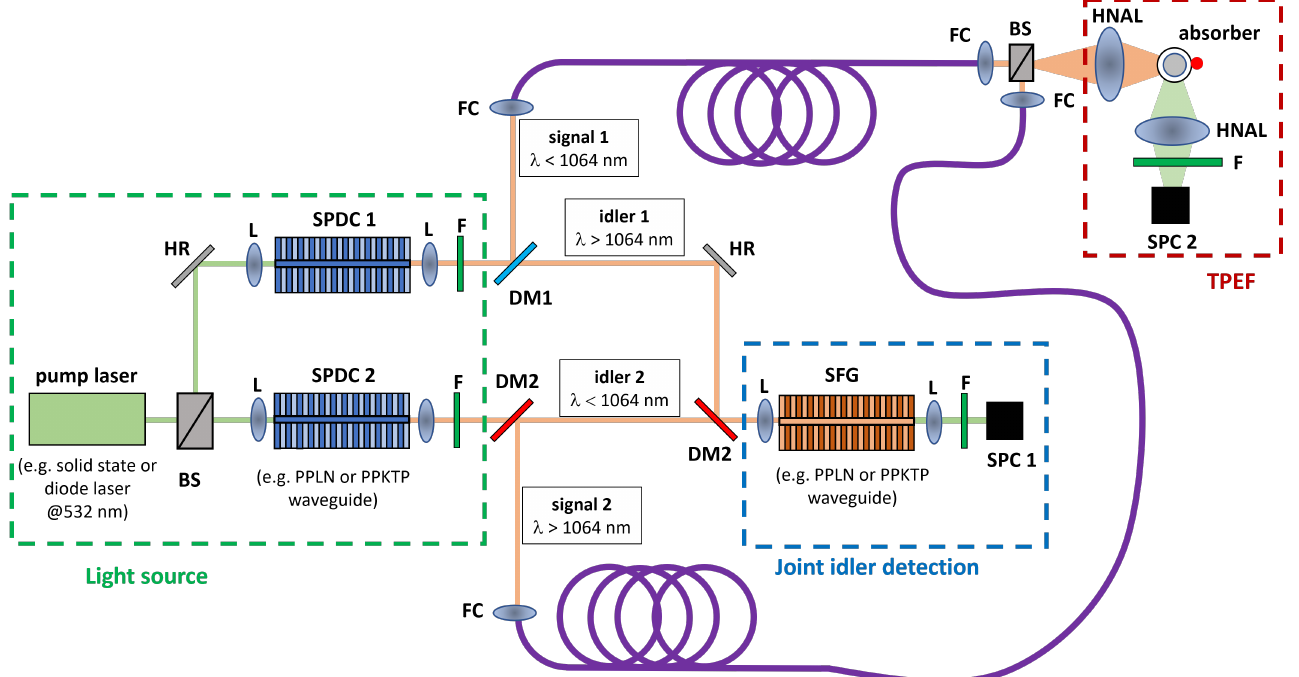
Figure 4. Sketch of a two-photon excited fluorescence (TPEF) experiment utilizing photon pairs from a heralded two-photon source to excite fluorescence in a single absorber (e.g., a dye molecule with a nano-antenna). A laser at a visible wavelength (e.g., 532 nm) is used to pump SPDC in two waveguide PP crystals (SPDC1 and SPDC2). The idler and signal photons of the SPDC sources are separated by dichroic mirrors (DM). Joint detection of the idler photons from both sources is performed in a waveguide nonlinear crystal by SFG and subsequent detection of an up-converted photon at a single photon detector (SPD 1). If two photons are jointly detected at the SFG crystal, two correlated/entangled photons must be in the two other channels. The delay between these two heralded photons can be controlled in fibers and/or by other means. The two-photons are reunified at a beam splitter (BS) and focused tightly onto the two-photon absorber using high NA optics (HNAL). The emitted fluorescence photons are collected with another high NA optic and are detected with another detector (SPD 2). The detection of the up-converted photon behind the SFG can herald the presence of two other photons that then can trigger two-photon excited fluorescence (TPEF) in a gated detection setup with an optical switch (OS) to reduce noise. BS—beam splitter, L—lens, F—optical filters, and FC—fiber coupling